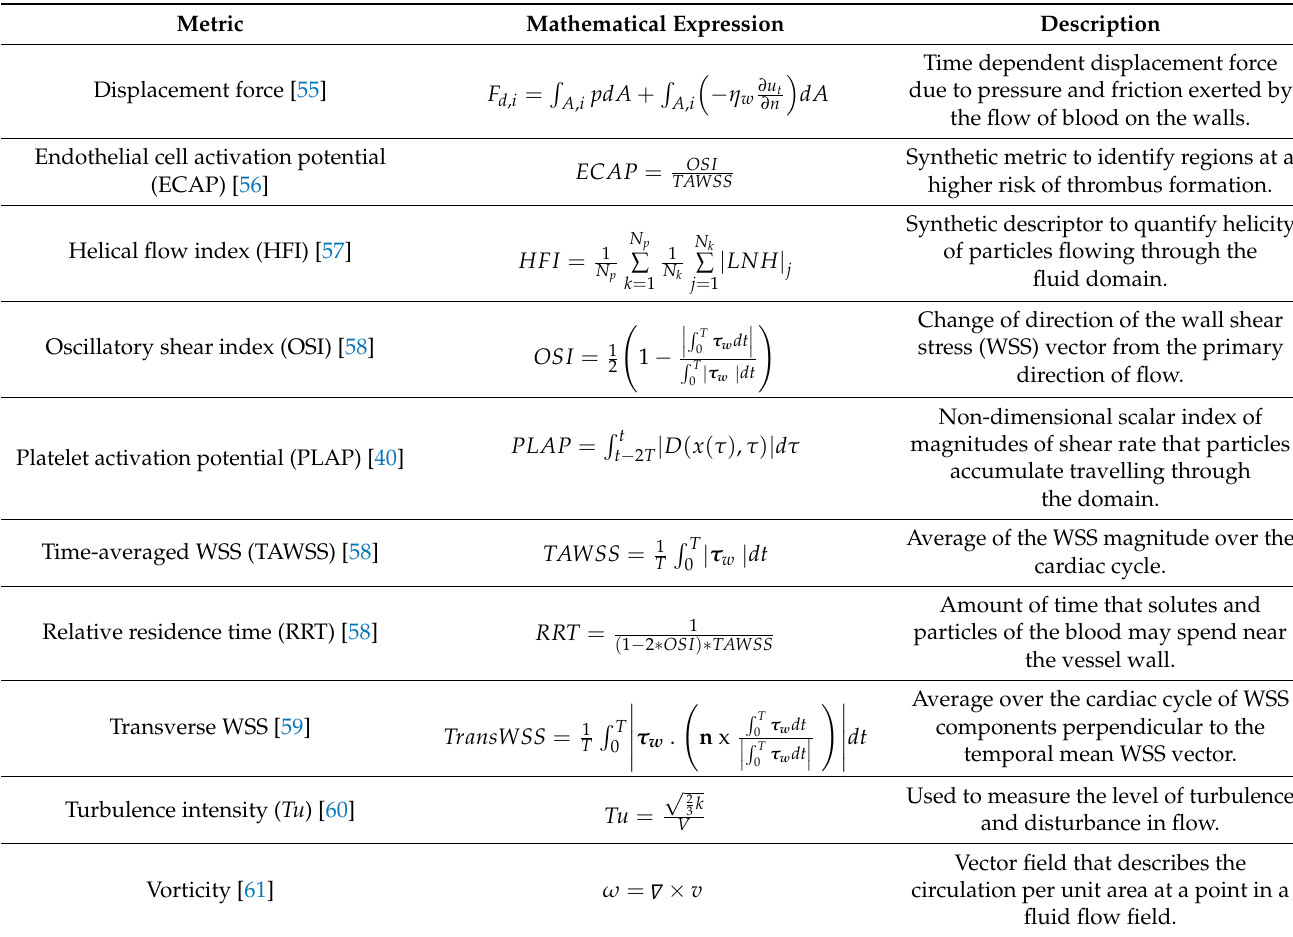
Table 2. Common haemodynamic indices used for computational analyses of aortic arch